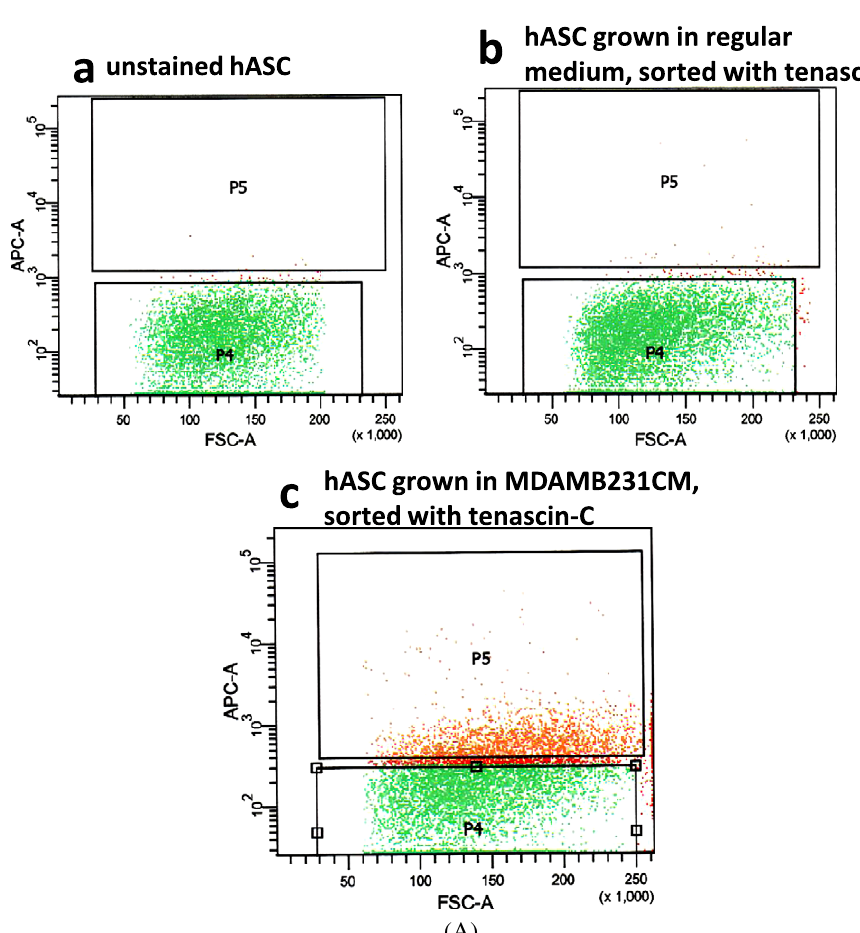
Fig. 8. Tenascin-C positive myofibroblasts produce elevated levels of CCL5. (A) FACS sorting analysis of hASCs for tenascin-C expression. Serum-starved hASCs were cultured in MDAMB231 conditioned medium (0% FBS; 24 h conditioning time) or serum-free regular growth medium over 4 days and subsequently sorted with FACS cell sorter using anti-tenascin-C antibody (5 µg/ml). Green dots in population P4 indicate tenascin-C negative cell counts; red dots in population P5 indicate tenascin-C positive cell counts. Representative images show cell counts from (b) FACS sorting of hASCs cultured in serum-free regular growth medium over 4 days (0.4% positive tenascin-C cells) and (c) hASCs grown in MDAMB231-CM over 4 days (24.8% positive tenascin-C cells). Unstained hASCs were used as negative control for sorting (a). (B) Cell fractions of tenascin-C positive and negative cells as sorted by FACS were cultured in regular growth medium over 4 days and conditioned medium from these cells was used for detection of CCL5 protein levels by ELISA. Data represent mean ± SD ( n = 3). * P < 0 . 0003. P4 – tenascin-C negative cell population; P5 – tenascin-C positive population; CM – conditioned medium. (The colors are visible in the online version of the